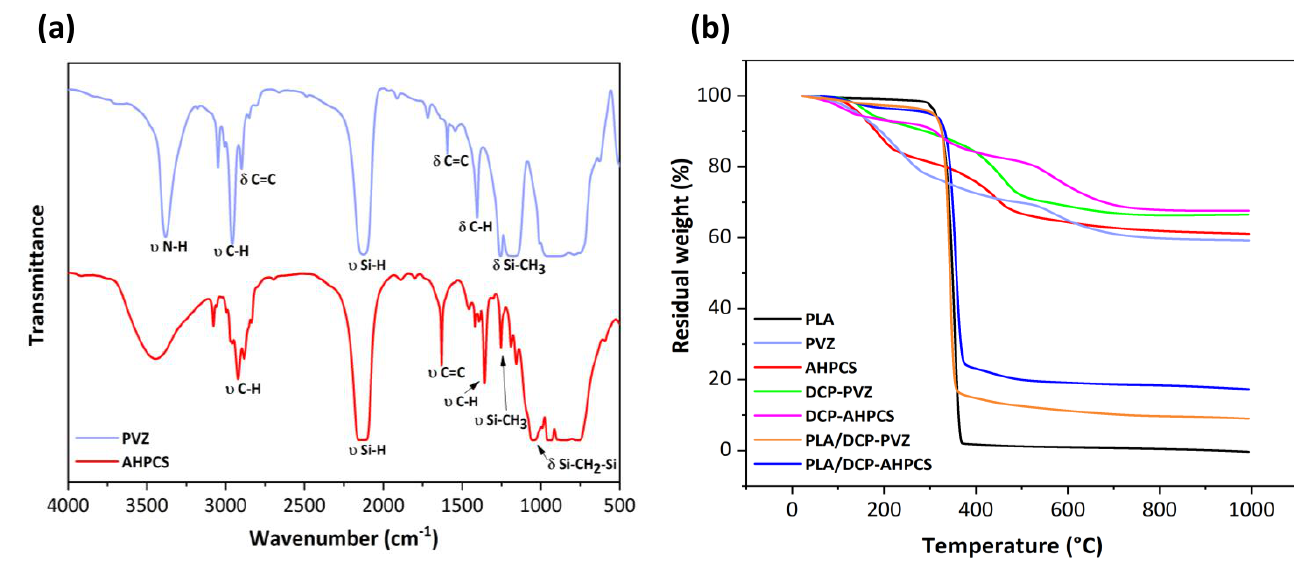
Figure 1. ( a ) FT-IR spectra of AHPCS and PVZ. ( b ) TGA plots recorded between room temperature and 1000 °C under inert atmosphere on PVZ and AHPCS, DCP-PVZ and DCP-AHPCS, PLA molds coated with preceramic polymers i.e., PLA/DCP-PVZ and PLA/DCP-AHPCS.